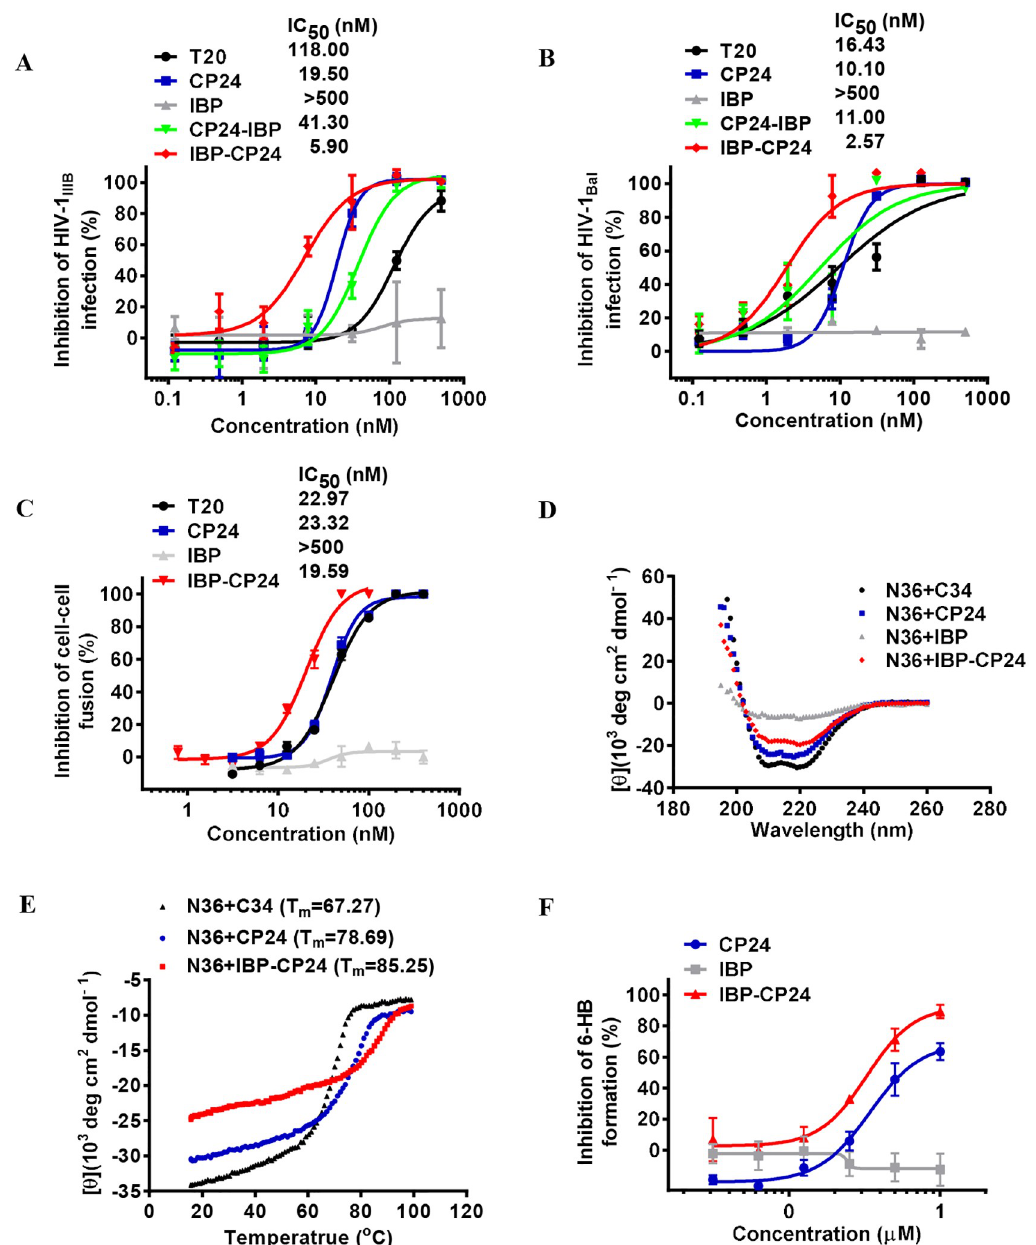
Fig 2. Inhibitory activities of IBP-conjugated peptides against HIV-1 infection and biophysical properties of CHR/NHR peptide complexes. (A) Inhibitory activities of T20, CP24, IBP, CP24-IBP and IBP-CP24 against infection of HIV-1 IIIB (subtype B, X4). (B) Inhibitory activities of T20, CP24, IBP, CP24-IBP and IBP-CP24 against infection of HIV-1 Bal (subtype B, R5). (C) Inhibition of Env-mediated cell-cell fusion between H9/HIV-1 IIIB cells and MT-2 cells. The data are presented as mean ± SD. (D) The secondary structure of the complexes of N36 and C34, CP24, IBP or IBP-CP24 was determined by CD. The circular dichroism spectra of these complexes displayed typical double minima at 208 and 222 nm for the α -helical feature. C34 and IBP were used as positive and negative controls, respectively. (E) Thermostability of the complexes of N36 with C34, CP24 or IBP-CP24 was measured by CD. (F) Inhibitory activities of CP24, IBP and IBP-CP24 against 6-HB formation between N36 and C34. Each sample was tested in triplicate and the data are presented as mean ± SD.